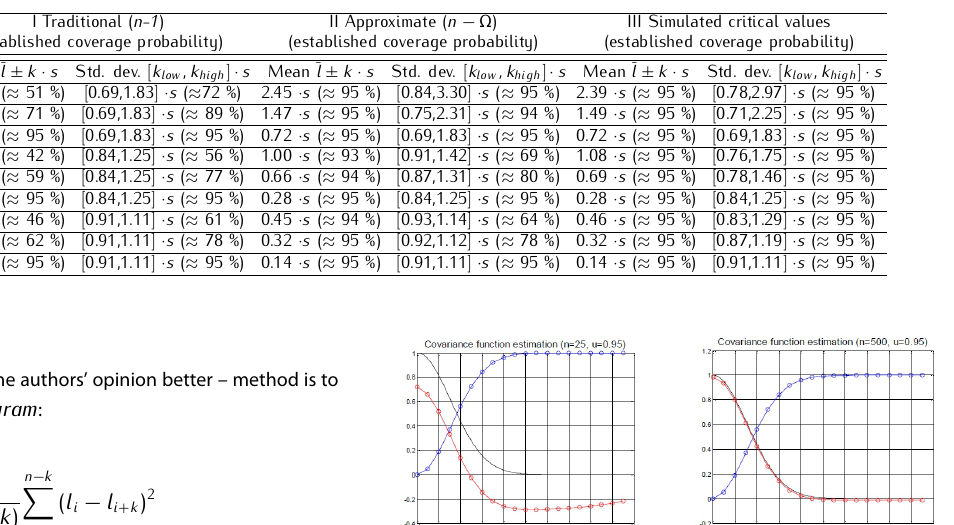
Table 2. Simulation study of different methods for the construction of confidence intervals for the mean and standard deviation, expressed as multiples ( k ) of the standard deviation ( s ). Nominal coverage probability: 95%; established probability in parenthesis. 100,000 sample runs in simulations.